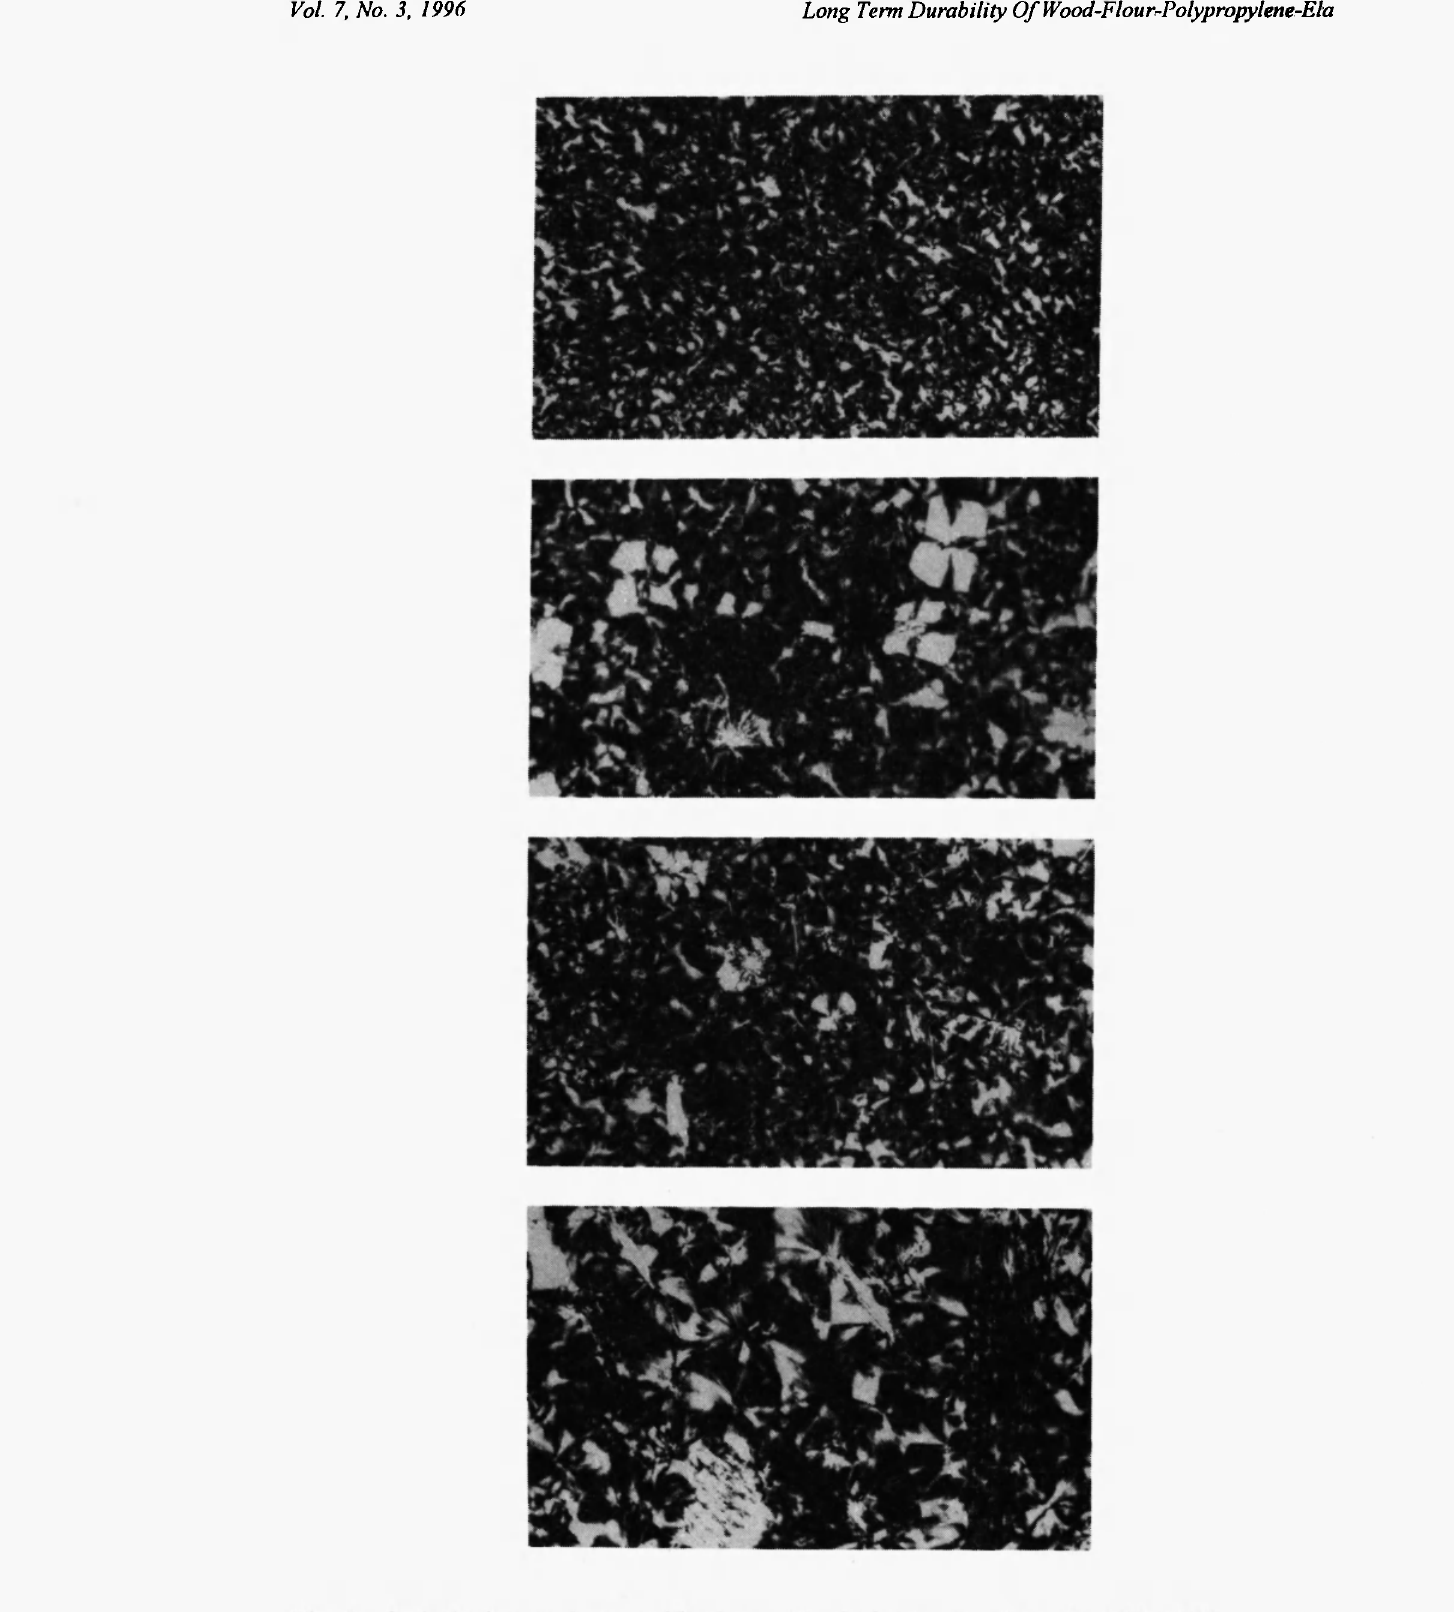
Fig. 6: Optical micrographs (magnification - x20) of microtome sections of: a) PP; b) PP containing 10% PI; c) PP containing 10% PI and 10% WF, and d) PP containing 10%